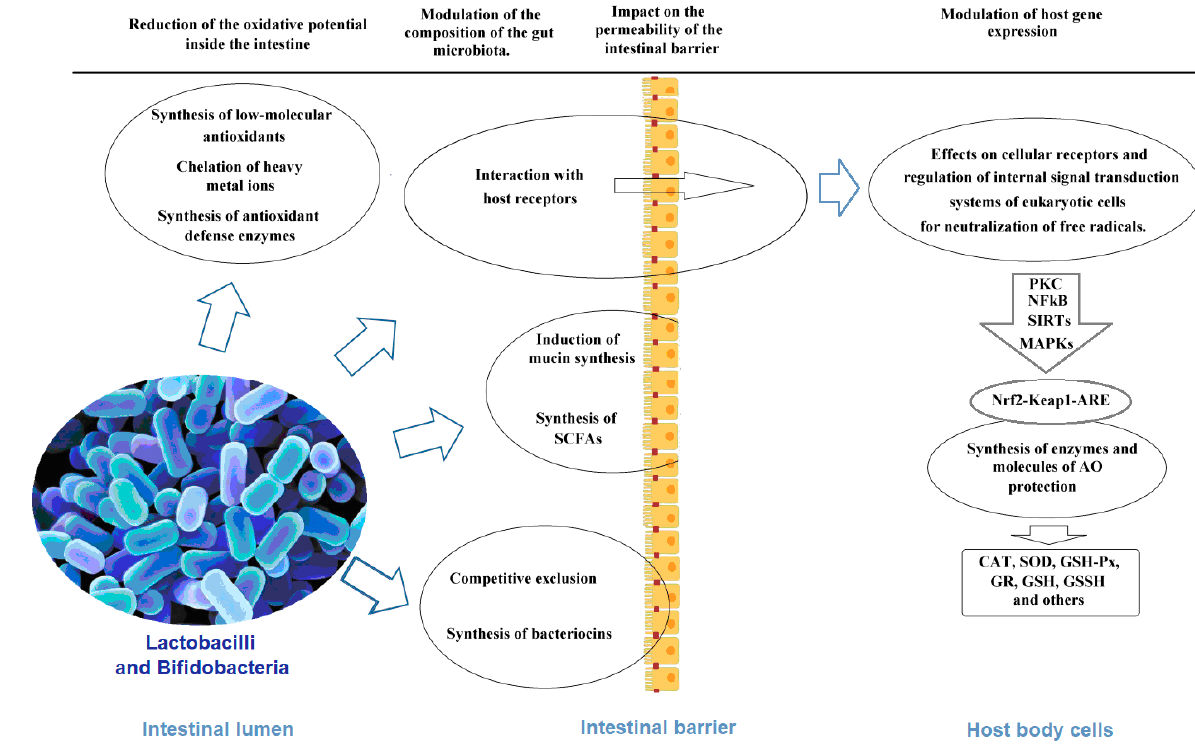
Figure 1. Mechanisms of antioxidant action of lactobacilli and bifidobacteria inside the intestine of the host.AO: antioxidant; OS: oxidative stress; SCFAs: short-chain fatty acids; NF- κ B: nuclear factor kappa B, eukaryotic transcription factor; SIRTs: a family of NAD-dependent protein deacetylases; PKC: protein kinase C; MAPKs: mitogen-activated protein kinases; SOD: superoxide dismutase; CAT: catalase; GSH: reduced glutathione; GSSH: oxidized glutathione; GSH-Px: glutathione peroxidase; GR: glutathione reductase; NRF2-Keap-ARE: a signaling system responsible for the expression of antioxidant-responsive elements (ARE-genes).